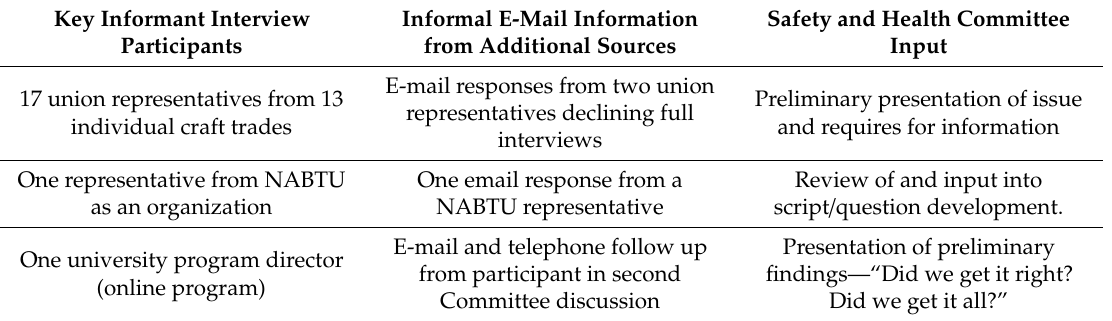
Table 3. Sources of qualitative